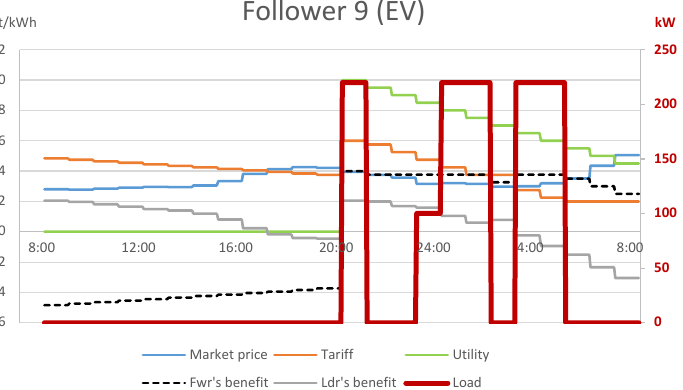
Figure 5. Optimistic tariff with least favorable follower response: consumption of follower 1 with household appliances.